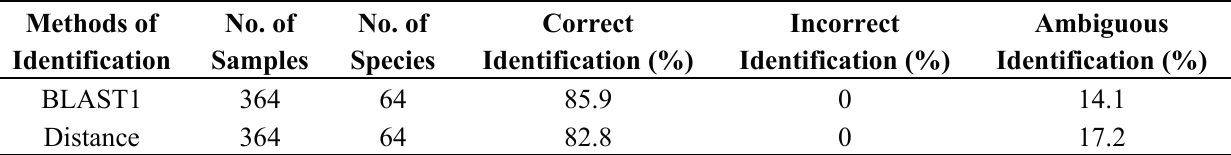
Table 2. Comparison of authentication efficiency for ITS2 using different